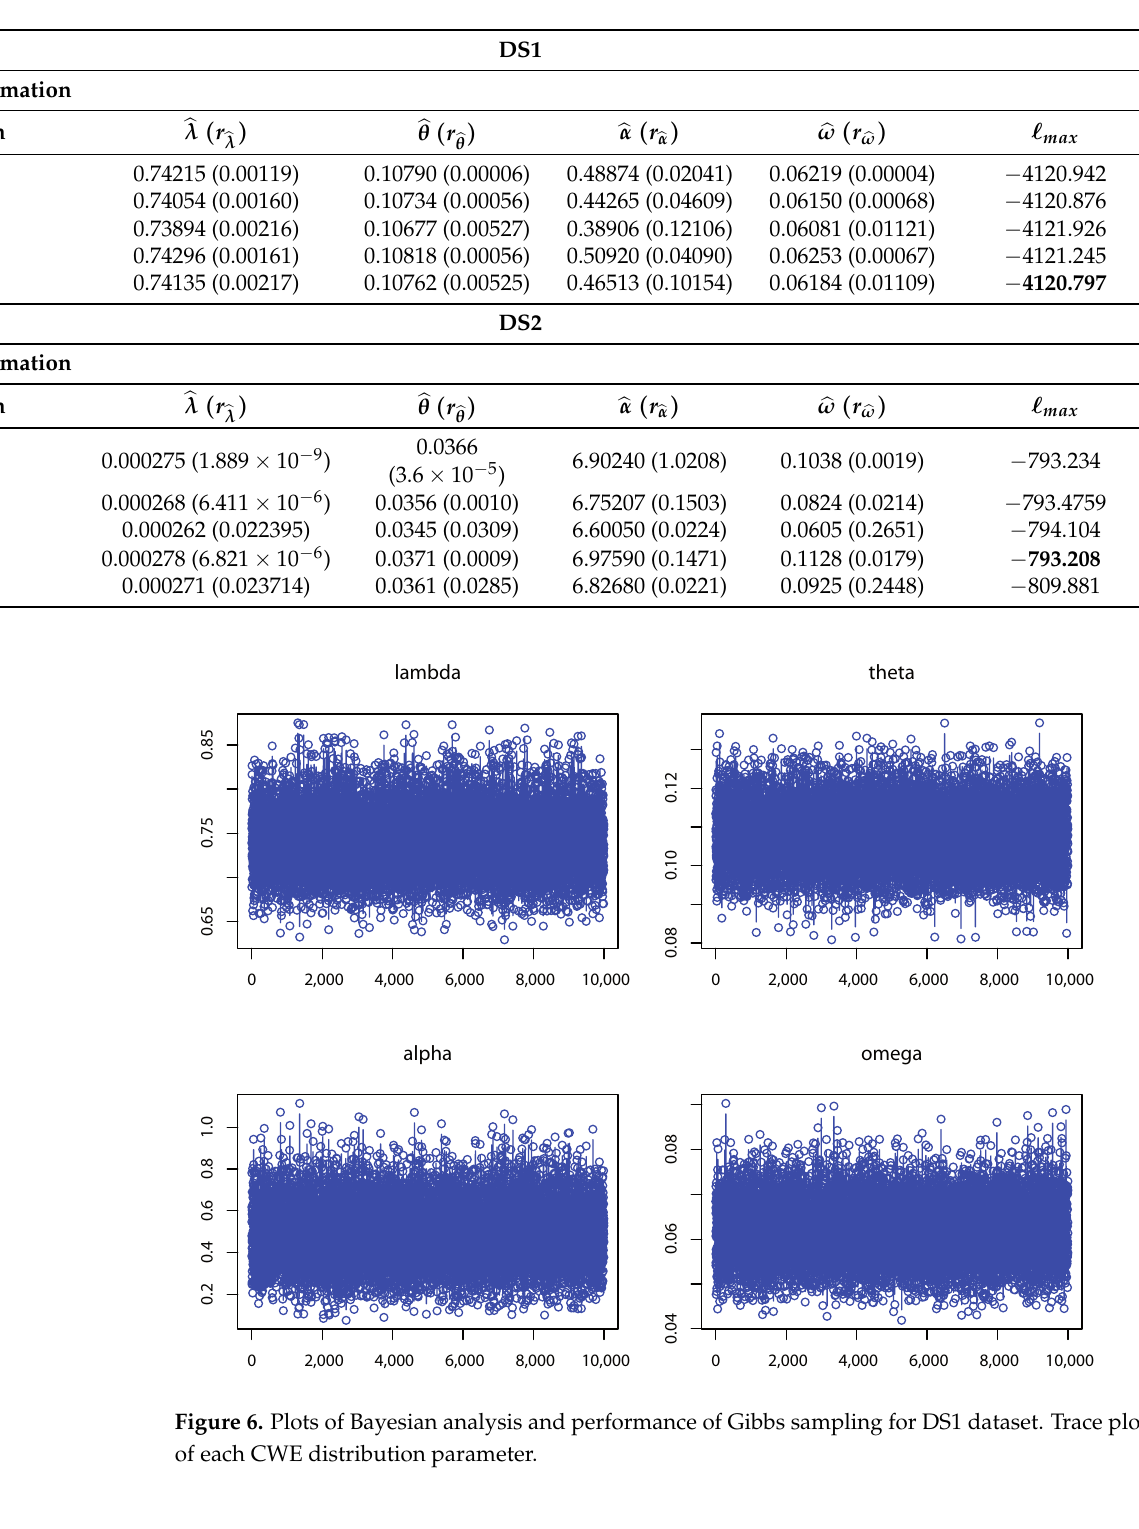
Table 4. Bayesian estimates and their posterior risks of the CWE distribution parameters under different loss functions based on DS1 and DS2 datasets. The bold entries highlight the highest (cid:96) max values for each model.